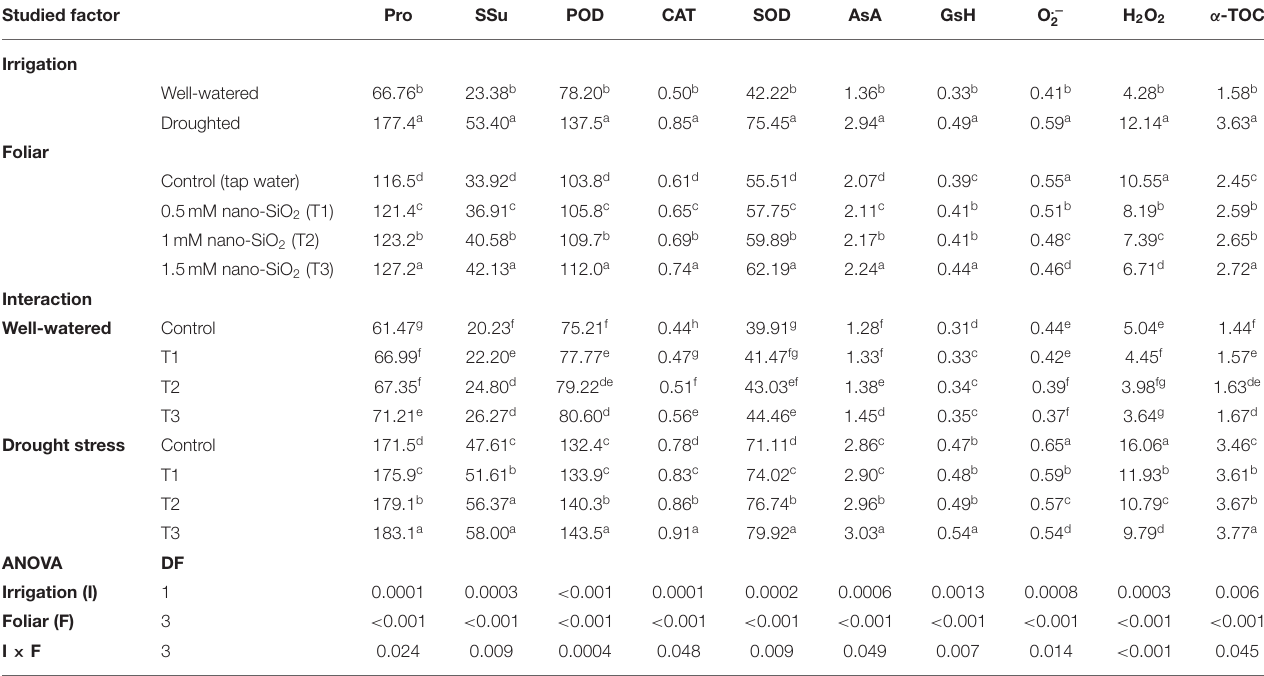
TABLE 3 | Impacts of nano-silicon dioxide (nano-SiO 2 ) foliar application on the proline content (Pro, µ mol g − 1 DW), soluble sugars (SSu, mg g − 1 DW), peroxidase activity (POD, unit mg − 1 protein), catalase activity (CAT, unit mg − 1 protein), superoxide dismutase activity (SOD, unit mg − 1 protein), ascorbic acid (AsA, µ mol g − 1